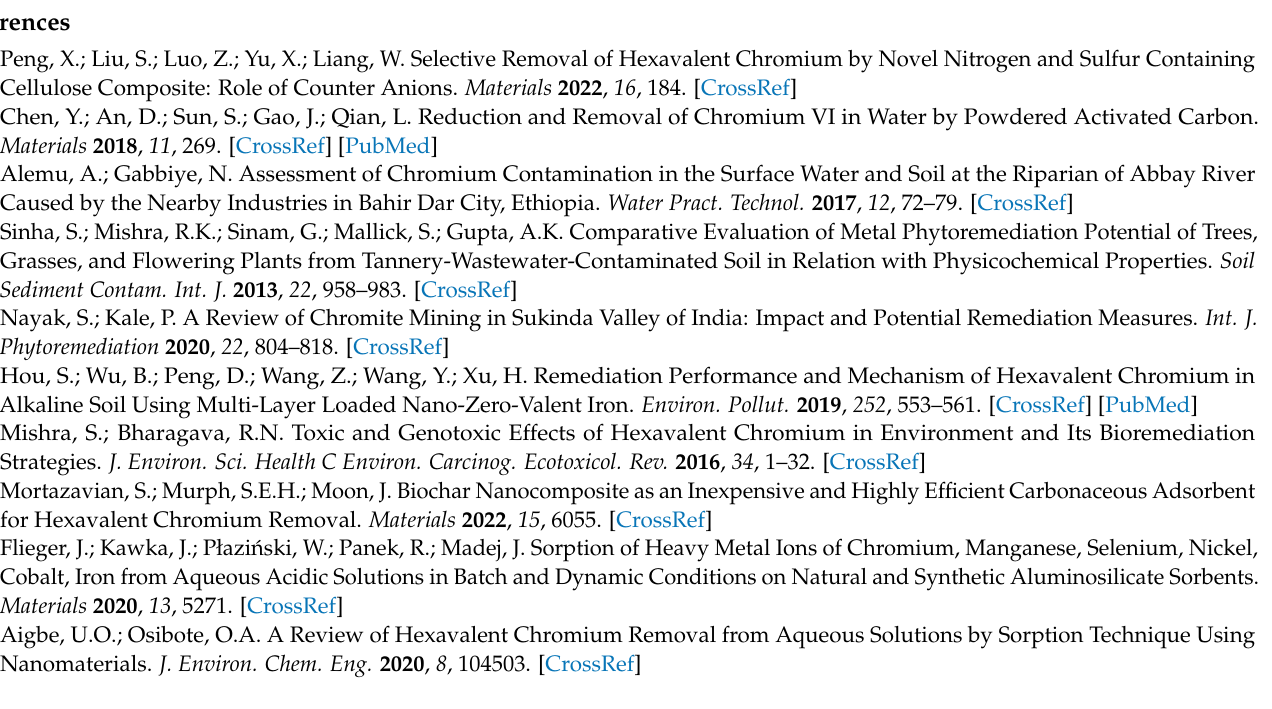
Table S2: Equations for isotherm models; Table S3: The calculated energies of interactions (in kcal/mol) between CrO 42 − ion and sorption sites, including the species formed in the reaction of neutralization; Figure S1: The plots for ( a ) IPD, ( b ) Bangham, ( c ) Boyd and ( d ) LFD models for removal of chromium on Fe 3 O 4 @APTMS/PGME-deta; Figure S2: The reaction of epoxy groups with deta and